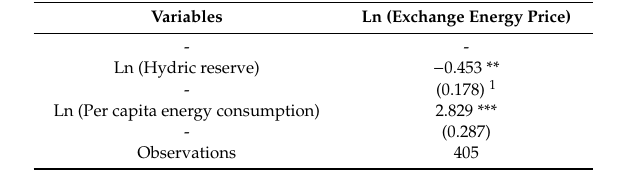
Table 5. Cointegrated